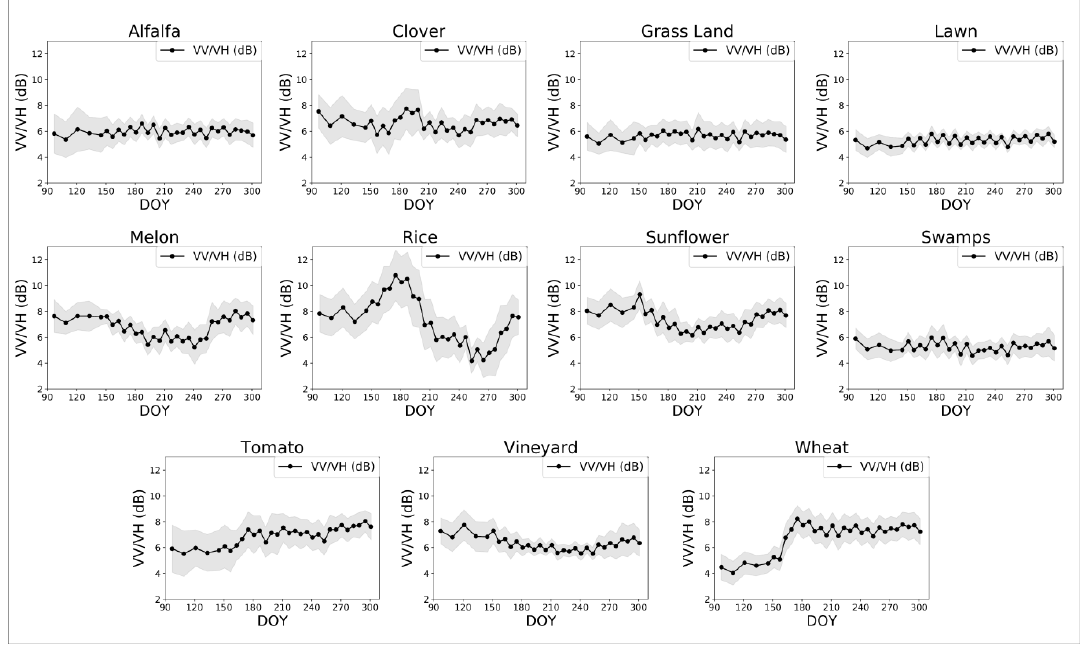
Figure 5. Temporal evolution of the ratio VV / VH for SAR backscattering coe ffi cient σ ◦ of 11 crop types. Mean values are represented by dots and standard deviations are represented by the filled color domains surrounding the curves.